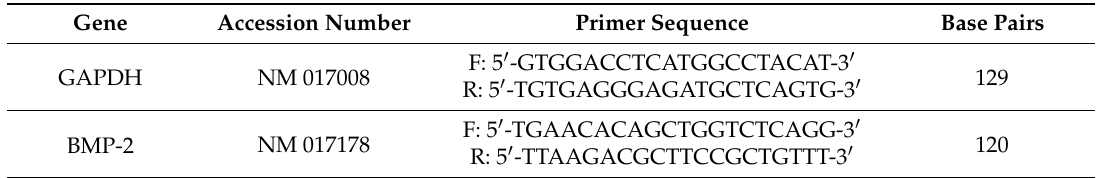
Table 1. Primers for GADPH and